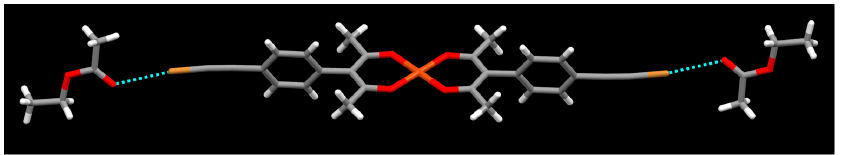
Figure 8. Part of the crystal structure of [Cu( L2 ) 2 ]·2C 4 H 8 O 2 showing the geometry around the metal ion and the ligand-solvent halogen bond (color codes: red—oxygen; gold—bromine; orange—copper).